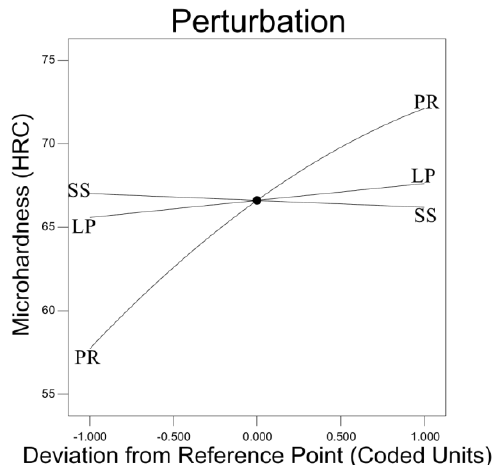
Figure 8. Impact of different parameters on micro-hardness.